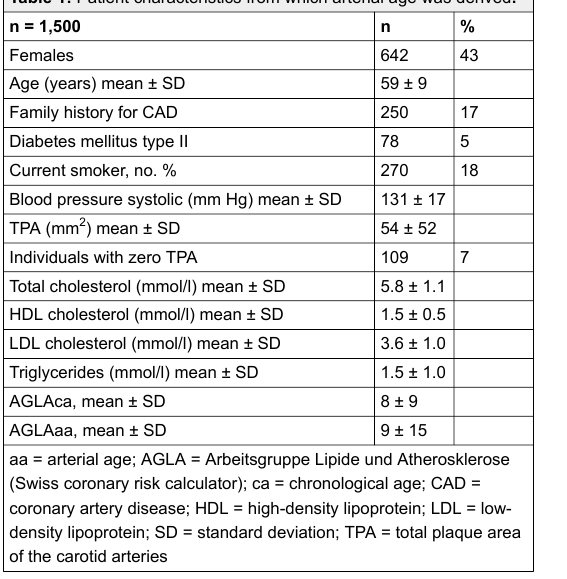
Table 1: Patient characteristics from which arterial age was derived .